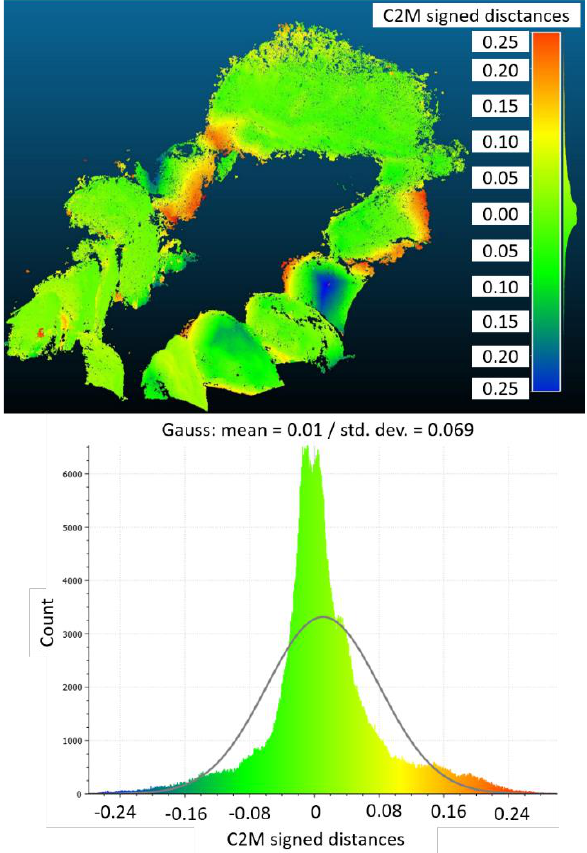
Figure 8: Cloud (historical point cloud) to mesh (modern model) distances in m and corresponding histogram.